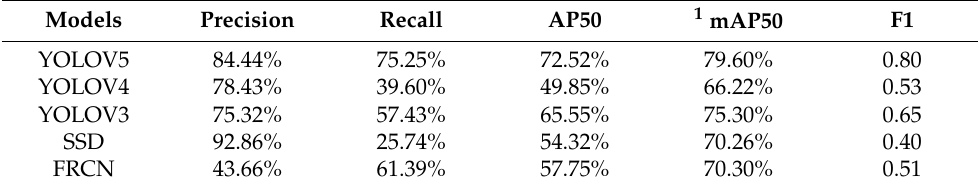
Table 2. The detection performances of litchi main stems under different models.